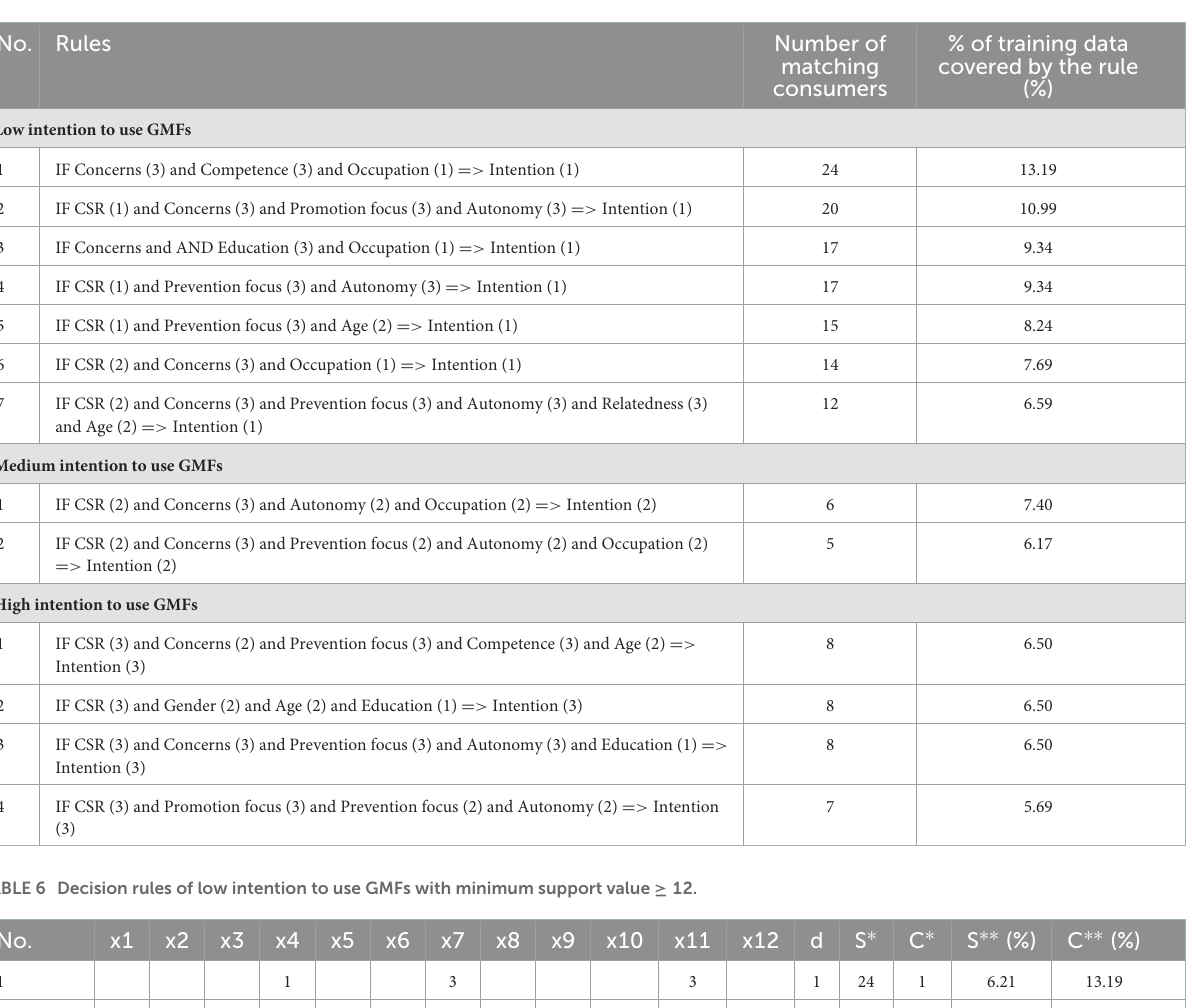
TABLE 5 Decision rules of consumers characteristics to use GMFs.